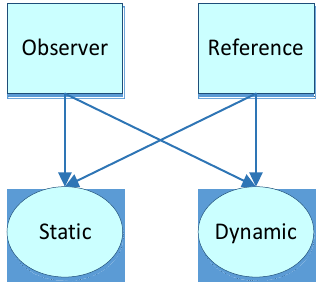
Figure 2. Indoor location classification matrix.